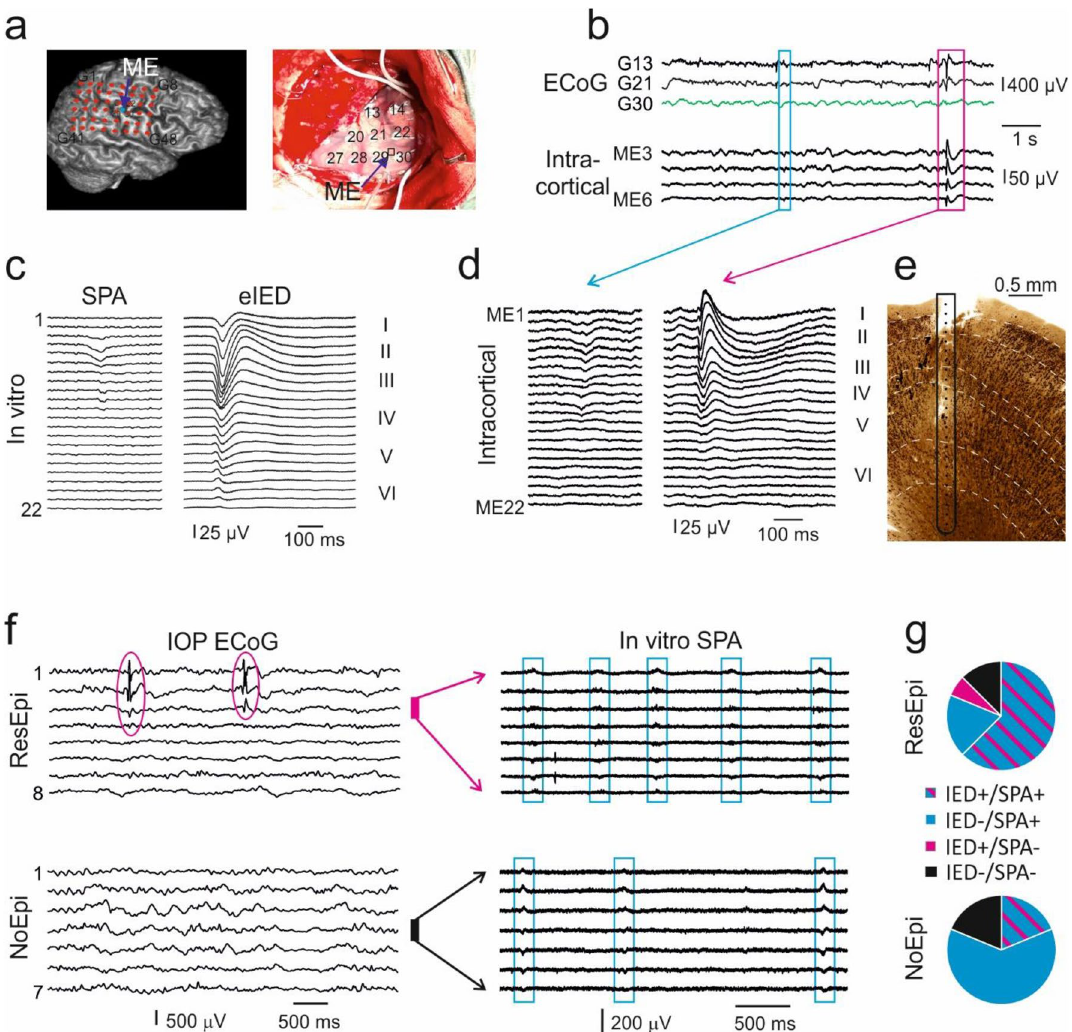
Figure 1. In vitro spontaneous population activity and interictal spikes resemble events recorded in vivo. ( a ) Example showing a multiple channel linear microelectrode (ME) chronically implanted into the neocortex of an epileptic patient below the clinical grid electrode, perpendicularly to the pial surface and covering all layers of the neocortex. ( b ) The clinical grid electrodes shown on ( a ) recorded the electrocorticography (ECoG) simultaneously with the local field potential gradient detected by the ME. ( c ) Two types of spontaneous synchronous activities were recorded in human neocortical slices in a physiological bath. In vitro experimental interictal-like epileptic discharge (eIED) emerged only in epileptic tissue and showed similar waveforms to in vivo recorded interictal spikes (( b ) magenta box, intracortical magnified on ( d )). Lower amplitude synchronous population activity (SPA on ( c )) was generated in slices derived from both epileptic and non- epileptic patients (this example was detected in the tissue sample resected from the patient shown in ( a , b )). Similar synchronous events were identified in intracortical recordings ( b , light blue box, intracortical magnified on ( d )). ( f ) In vitro SPA emerged in specimens with and without interictal epileptic discharges (IED, magenta circle) observed on the intraoperative ECoG (IOP ECoG), both in ResEpi and NoEpi tissue. The thick magenta line shows the location of the tissue sample obtained from a ResEpi patient, generating SPA in postoperative slices. The thick black line shows the location of a NoEpi tissue specimen which initiated SPA in vitro, during the postoperative experiment. ( g ) Ratio of tissue samples showing or not showing in vivo intraoperative IEDs (IED+ and IED−, respectively) in comparison with its ability to generate (SPA+) or not generate (SPA−) SPA in postoperative in vitro experiments. Note that the majority of the samples without IED were generating SPA in NoEpi patients